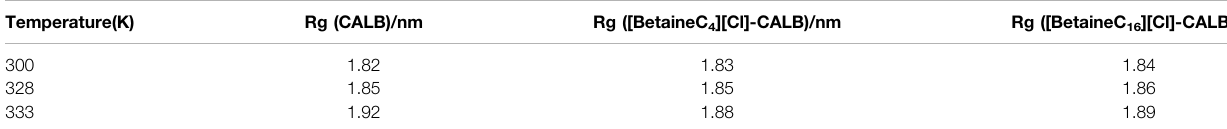
TABLE 4 | Rg of native and modi fi ed CALB at different temperatures. Temperature(K)